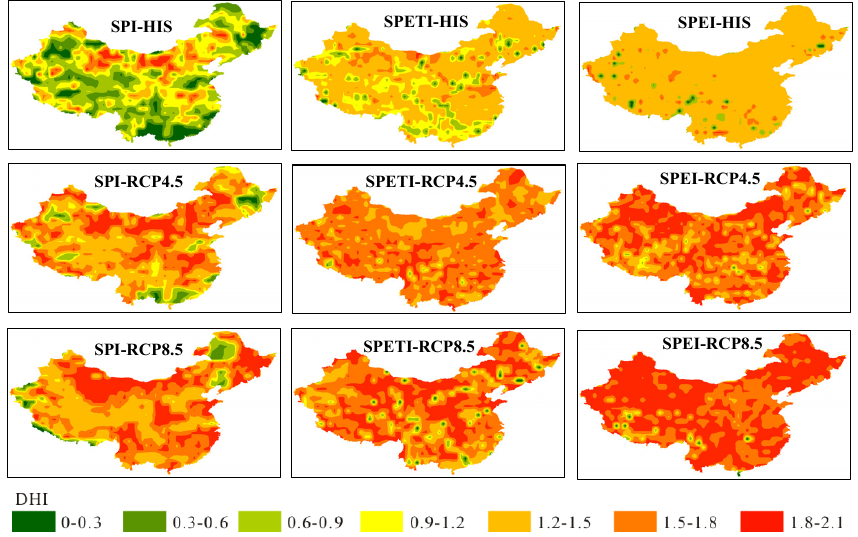
Figure 10. The distribution of the drought hazard index for different clusters. Table 5. Drought hazard indices for the different clusters.